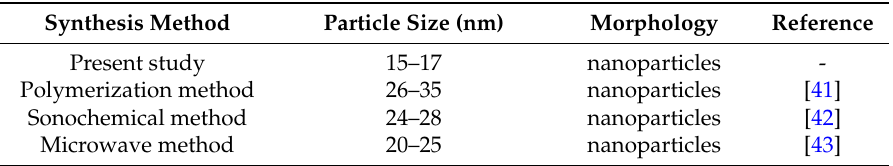
Table 2. Comparison of NiO activity with other reported